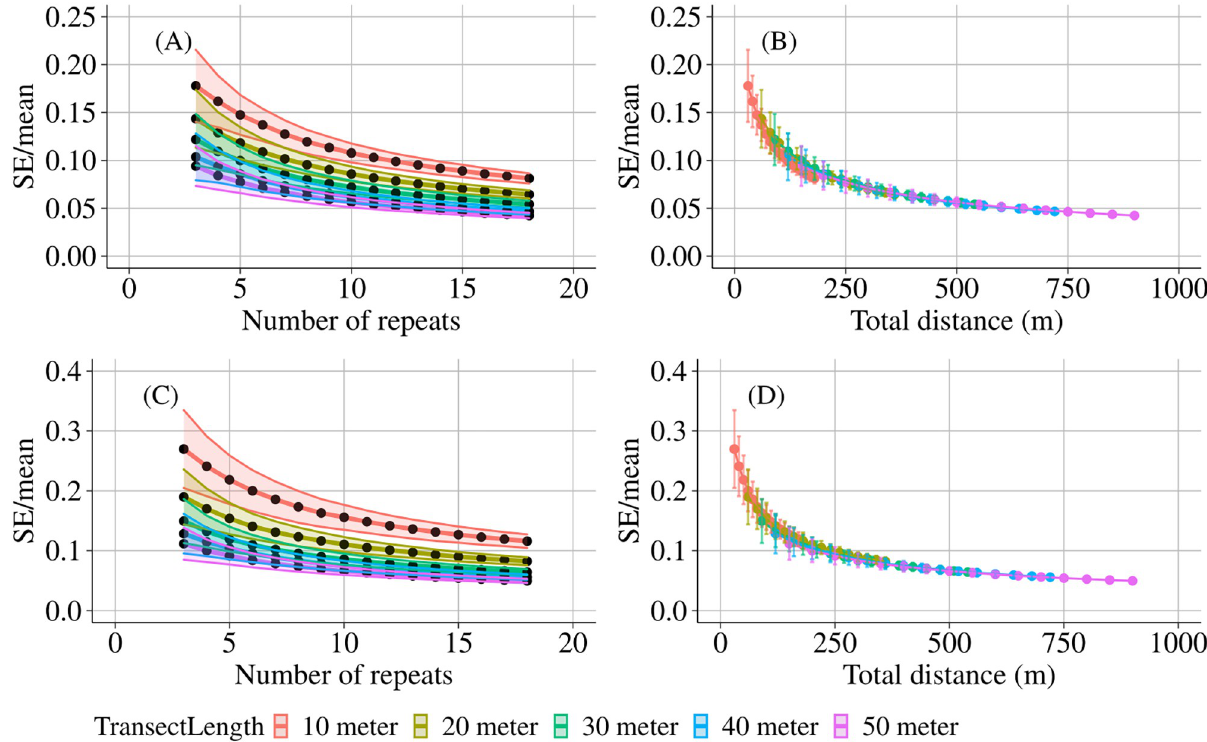
Fig 4. Univariate precision estimates of species density and Shannon diversity. Estimates of the standard error over the mean for species density (A) and Shannon diversity (C) in function of the number of repeats. Precision is defined as the inverse of the standard error over the mean. In (B) and (D) the standard error over the mean of species density and Shannon diversity is given as a function of the total swim distance. Total swim distance is defined as the number of repeats multiplied by the transect length. Different transect lengths were considered ranging from 10, 20, 30, 40 to 50 meters. Monte Carlo simulations (n = 10 4 ) were applied to determine the standard error over the mean per transect. The average values over all transects are visualized. The error bars represent the 95% confidence intervals which were constructed using the pooled standard deviation of the